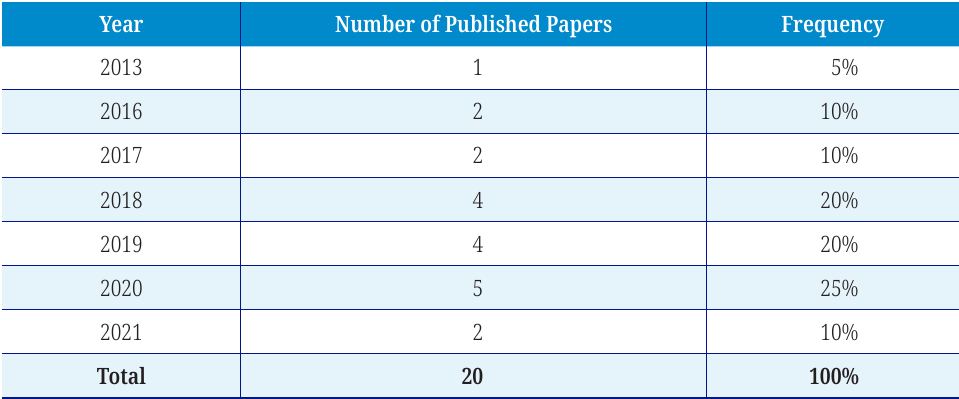
Table 2. Statistics of articles on prediction and prescription of